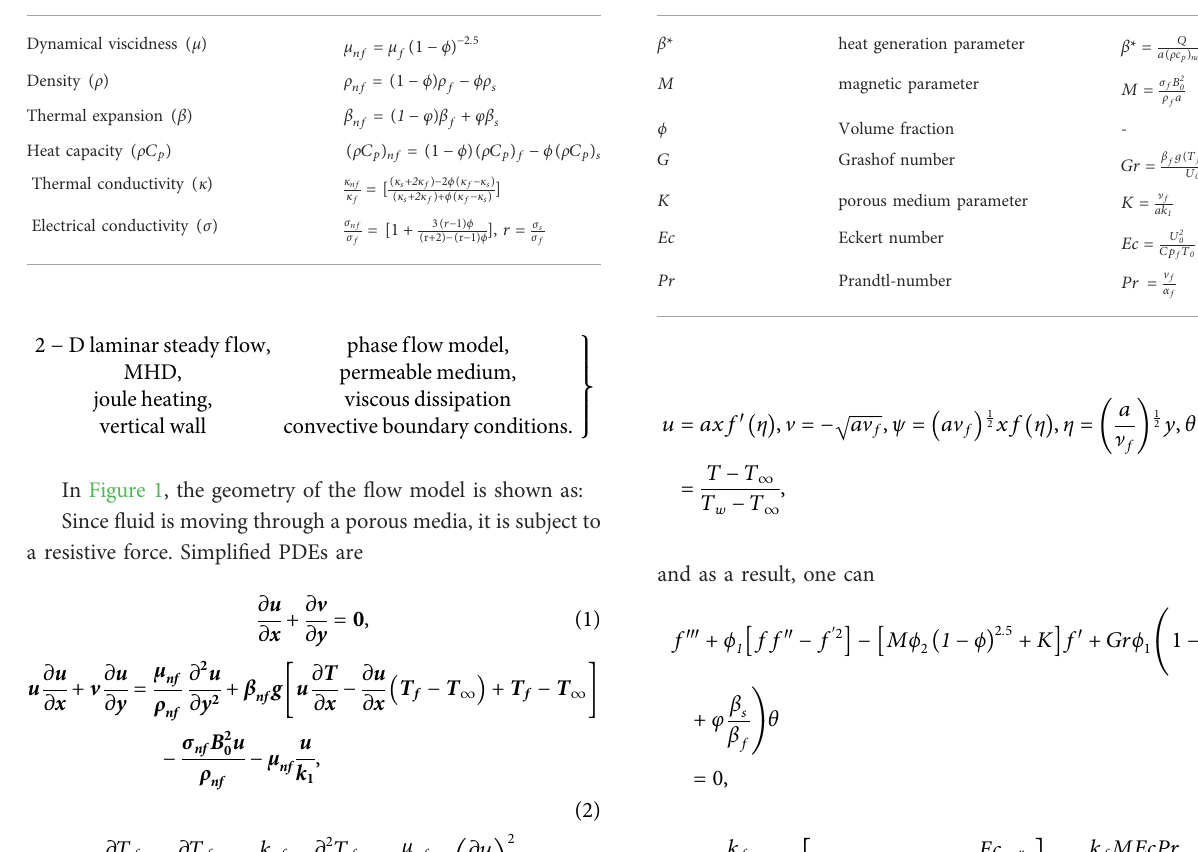
TABLE 1 Nano fl uid thermophysical properties are (Goud, 2020). Features